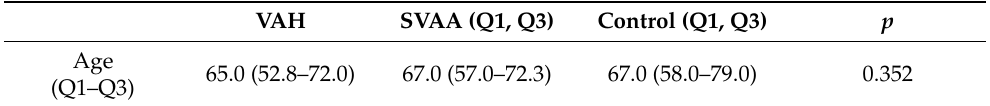
Table 2. Median age of